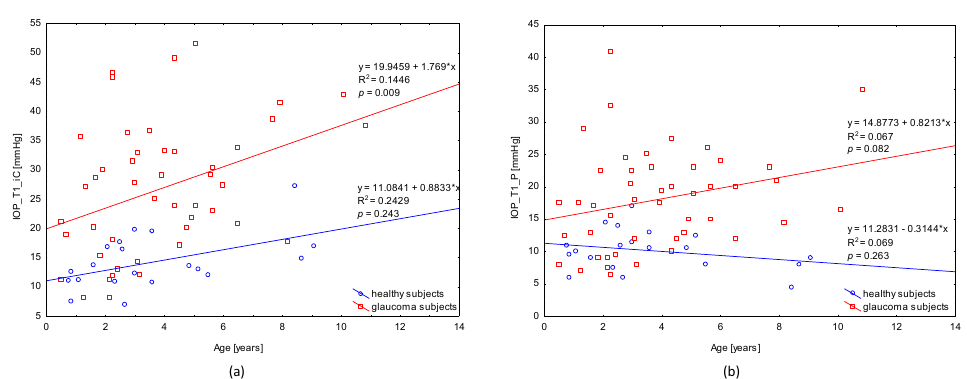
Figure 6. Correlation of age and IOP for ( a ) iCare and ( b ) Perkins at T1. Abbreviation: IOP: intraocular pressure; IC: iCare; P: Perkins; y: function; x: age; R 2 : regression squared error metric; p : p -Value.